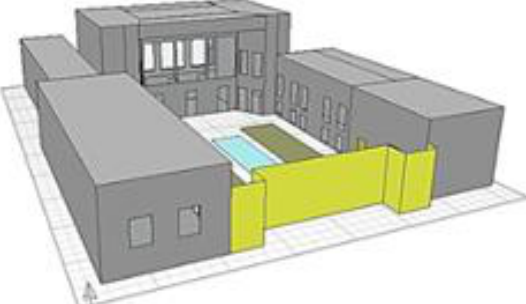
Figure 10 Geometry of house No. 2; south facing